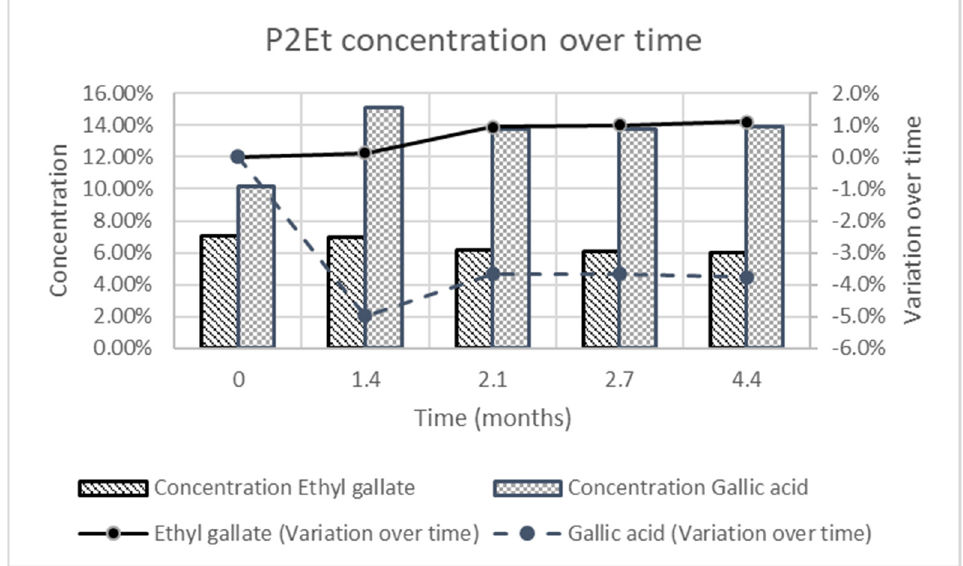
Figure 4. Variation of P2Et concentration over time according to gallic acid and ethyl gallate concentration over time. The standard deviation of ethyl gallate variation over time were 0.19%, 0.38%, 1.53%, 1.61% and 1.76% at the di ff erent times (0, 1.4, 2.1, 2.7 and 4.4 months), whereas for the same time the standard deviation of gallic acid variation over time were 0.01%, 3.63%, 3.26%, 3.30% and 3.46%.